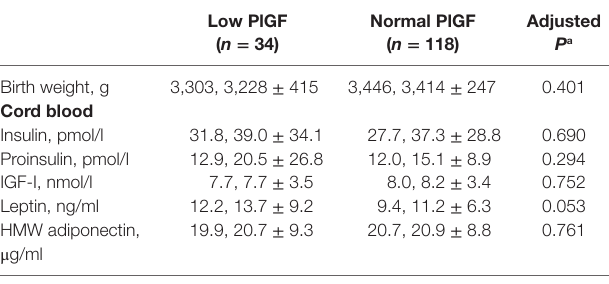
TaBle 5 | Birth weight and metabolic health biomarkers in cord blood comparing infants with low ( < 25th percentile) vs. normal maternal circulating PlGF concentrations within the control (birth weight 25th–75th percentile)